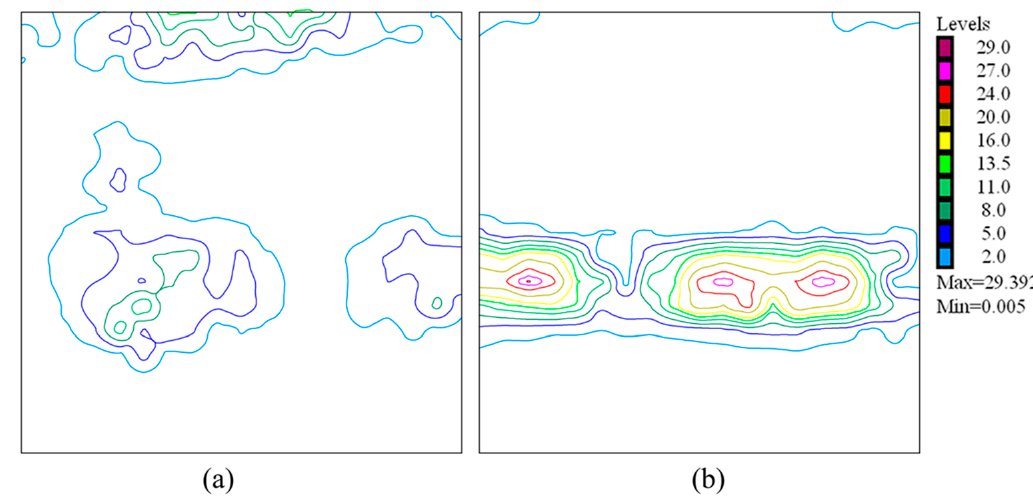
Figure 2. The Orientation distribution function (ODF) sections ( φ 2 = 45°) of 70% clock-rolled Ta plates along the thickness: ( a ) Surface layer, ( b ) center layer.